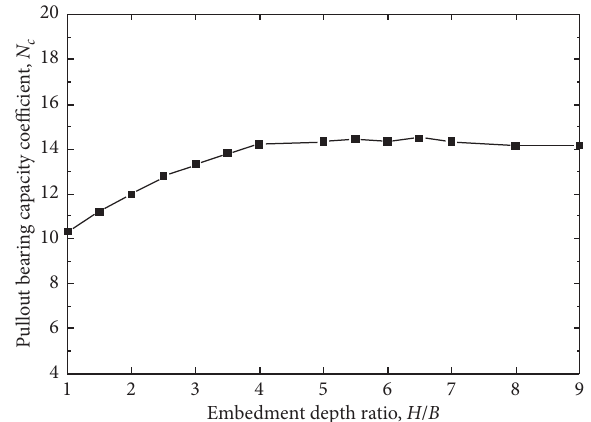
Figure 12: Variation in N c with embedment depth in the single- layer soil (normally consolidated soil).